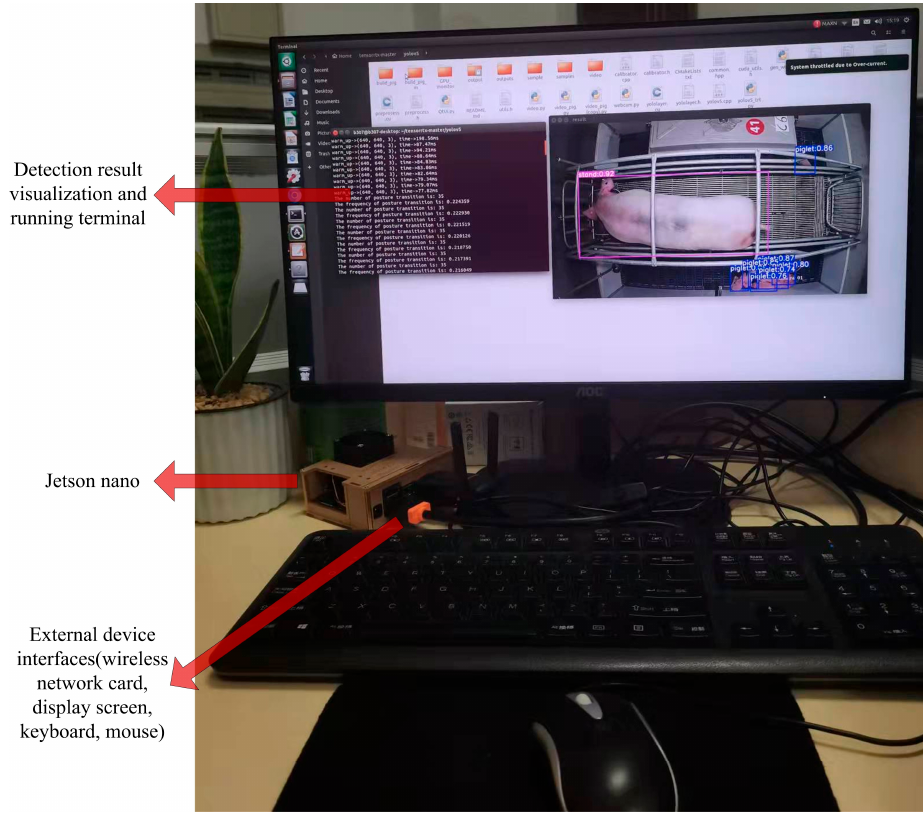
Figure 8. Jetson Nano running effect.